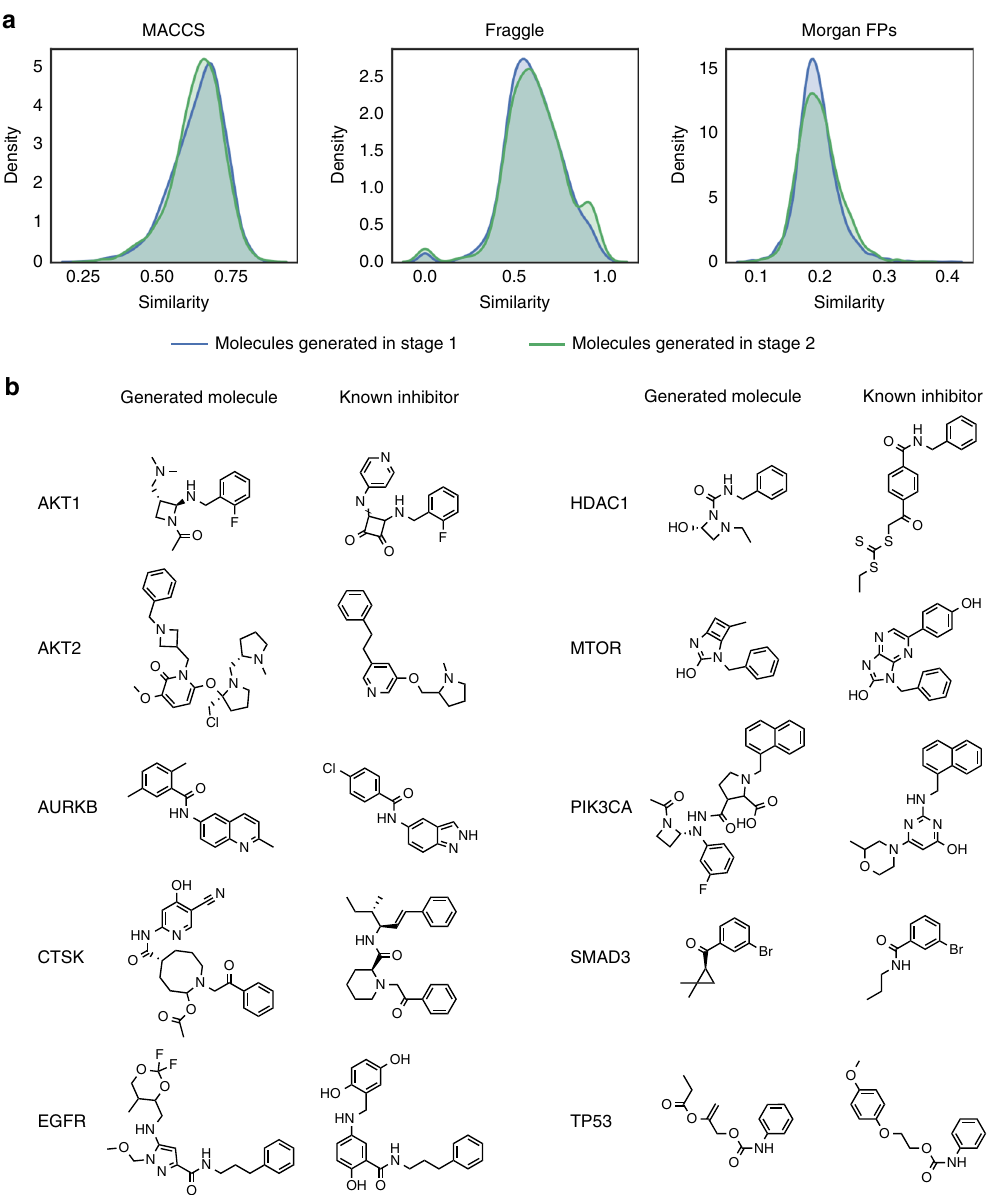
Fig. 3 Molecules generated from target knock-out gene expression signatures. a Distribution of similarity between all generated molecules and their closest active nearest neighbor using MACCS, Fraggle and Morgan Fingerprints for Stage I in blue and Stage II in green. b Chemical structures of some generated molecules and their closest active nearest neighbor for each of the ten different